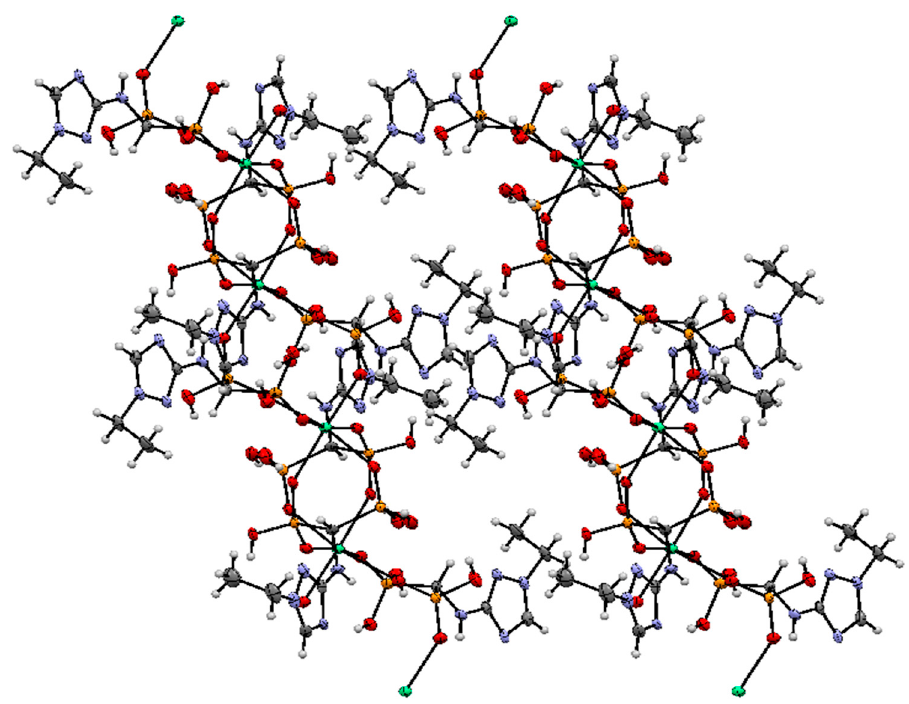
Figure 3. The crystal packing of compound 2 viewed along the b axis.